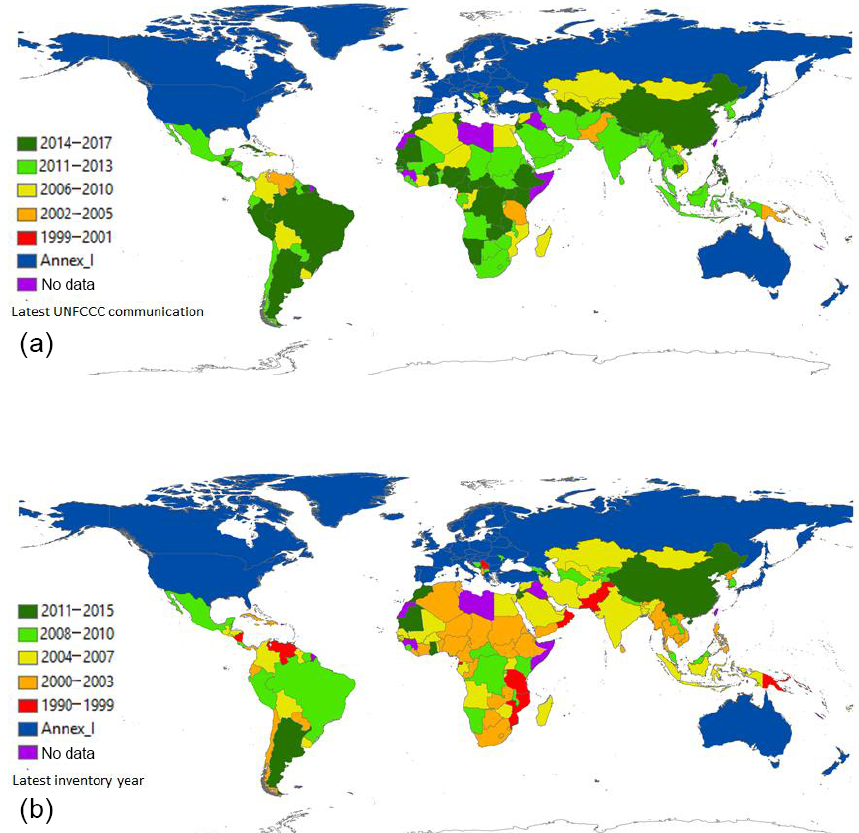
Figure 1. (a) Inventory submission as received at UNFCCC (by January 2017) for all countries: expressed with the year of emission reporting in which the latest national communication to UNFCCC took place. (b) Inventory submission as received at UNFCCC (by January 2017) for all countries expressed with the latest year of emission that is covered in the inventory submitted to UNFCCC.